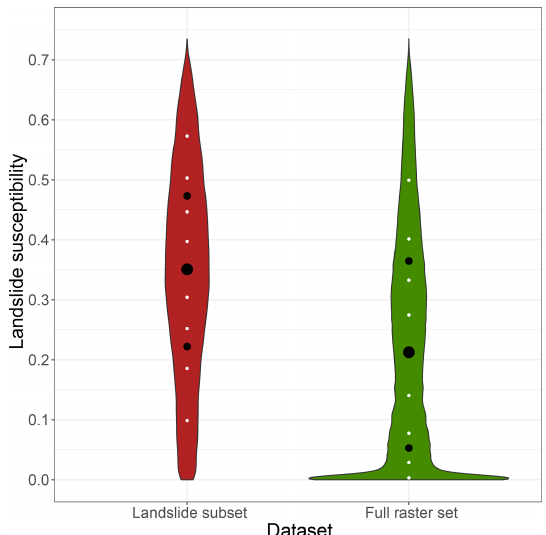
Figure 3. Density of landslide susceptibility values in landslide ar- eas as well as across the whole study area. White dots indicate per- centiles of the distribution (in steps of 0.1), and black dots indi- cate the quartiles of the distribution. Note that densities for both violin plots are displayed independently (as opposed to the condi- tional probability in the case of landslides) for visualisation pur- poses. Consequently, sizes of the susceptibility density are not on the same scale and thus not directly